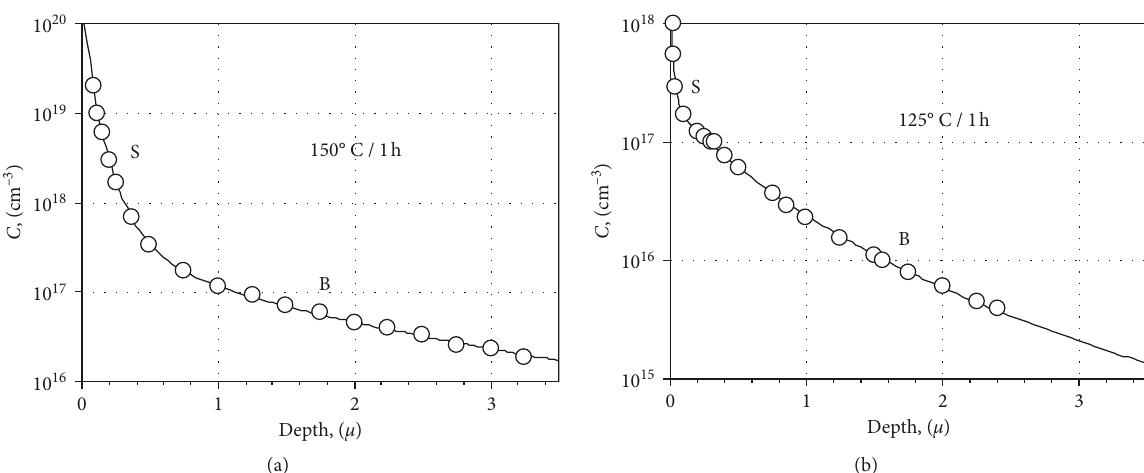
Figure 5: Concentration profiles in lightly doped n-Si. (a) Annealing at 150 ° C for 1 h [3]. (b) Annealing at 125 ° C for 1h [17]. Each component of a profile, S and B, is described by Equation (2) The deduced values of D / r were strongly different for two close temperatures: 150 ° C (Figure 4(a), D / r (cid:28) 0.8 cm/s) and 125 ° C (Figure 4(b), D / r 0.015 cm/s). (cid:28)